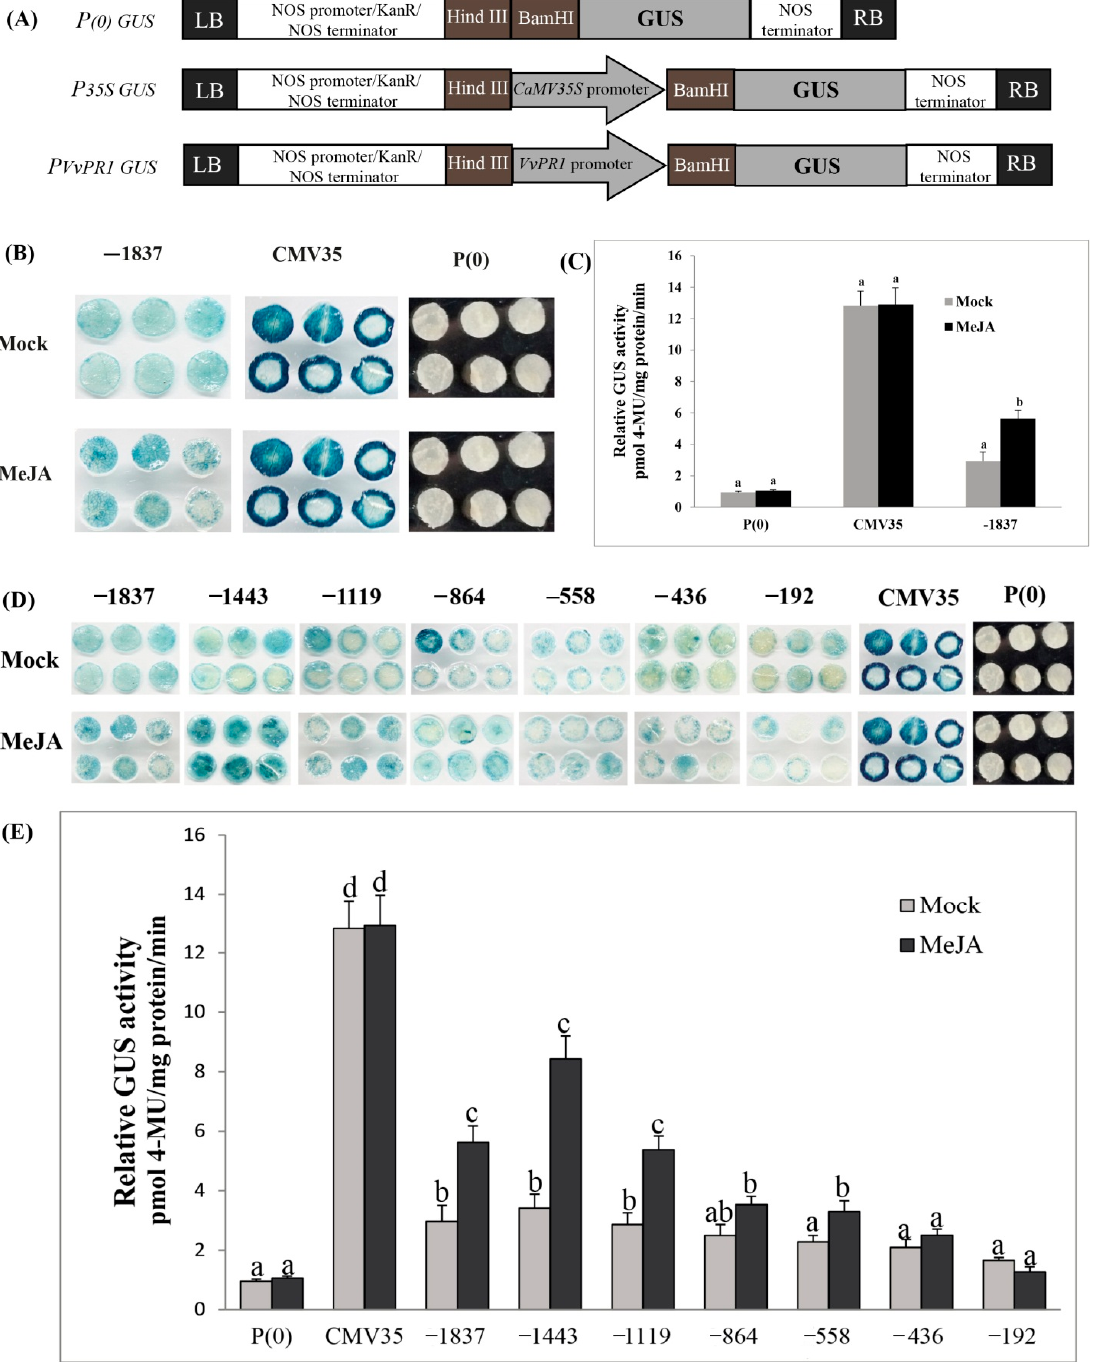
Figure 6. ( A ) Scheme of GUS vector construction. ( B ) Histochemical staining analysis of the full-length promoter of VvPR1 Gene with the positive and negative control. ( C ) Fluorometric analysis of the full-length promoter of the VvPR1 gene with positive and negative control. ( D ) Histochemical staining analysis; transiently transformed GUS expression in N. benthamiana leaves with serially deleted VvPR1 promoter fragments ( − 1837, − 1443, − 1119, − 845, − 558, − 436, and − 192 pb) against different phytohormones methyl jasmonate (MeJA). ( E ) Fluorometric analysis; transiently transformed GUS expression in N. benthamiana leaves with serially deleted VvPR1 promoter fragments ( − 1837, − 1443, − 1119, − 845, − 558, − 436, and − 192 pb) against MeJA. The different letters on bars in this figure represents a significant difference according to the least significant difference (LSD) ( p < 0.05) in serially deleted VvPR1 promoter fragments against MeJA